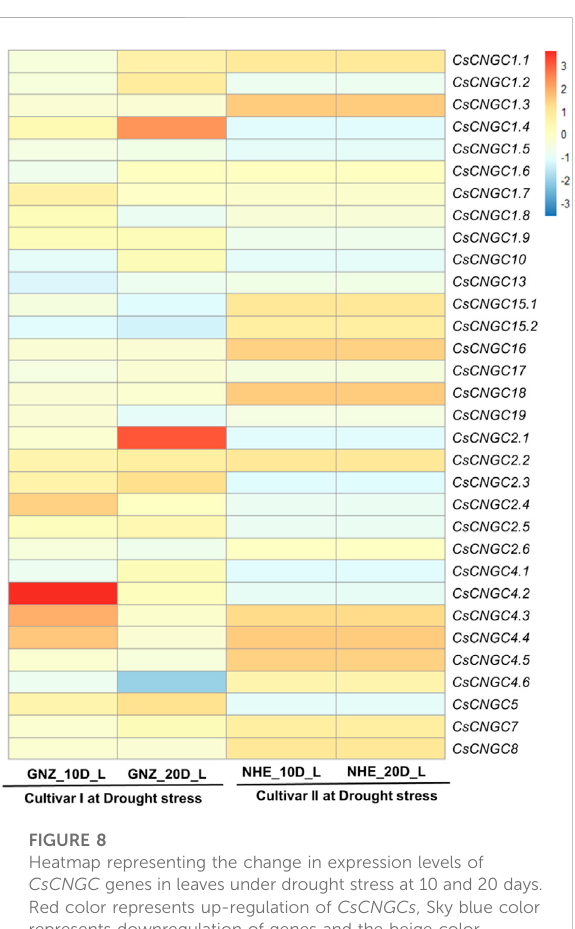
FIGURE 8 Heatmap representing the change in expression levels of CsCNGC genes in leaves under drought stress at 10 and 20 days. Red color represents up-regulation of CsCNGCs , Sky blue color represents downregulation of genes and the beige color represents no change in